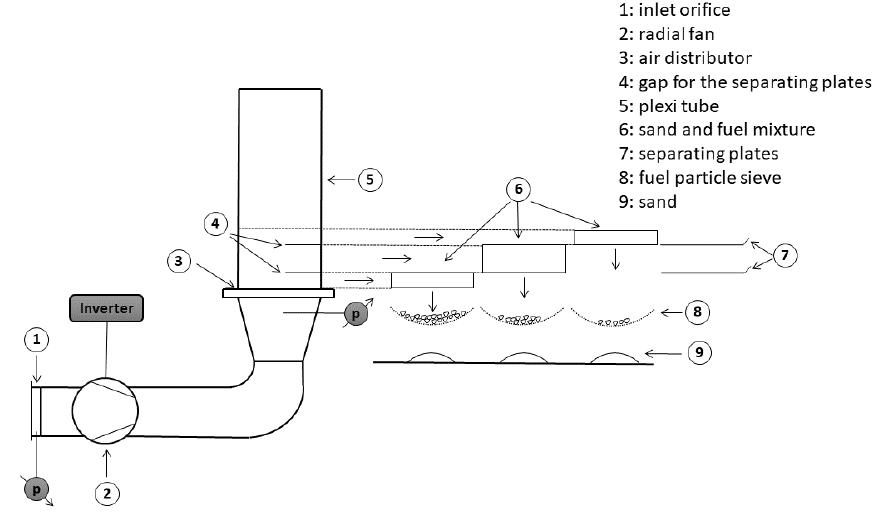
Figure 4. Schematic of the measuring setup and method of the particle mixing